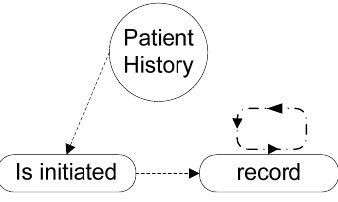
Figure 9. ORM sub-scheme for object type Patient